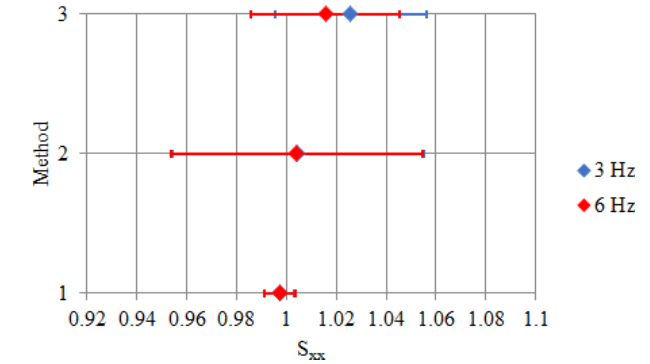
Figure 7. MEMS accelerometer: comparison between methods (main sensitivity along the y axis, S yy ).